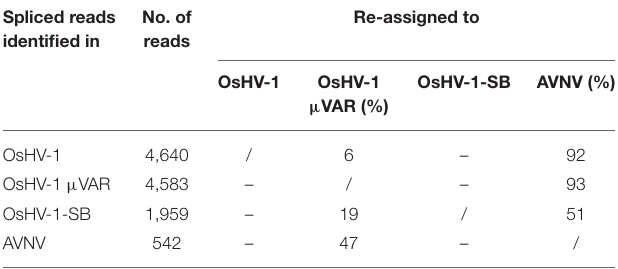
TABLE 6 | Re-assignment of spliced reads to M alacoherpesviridae genomes.